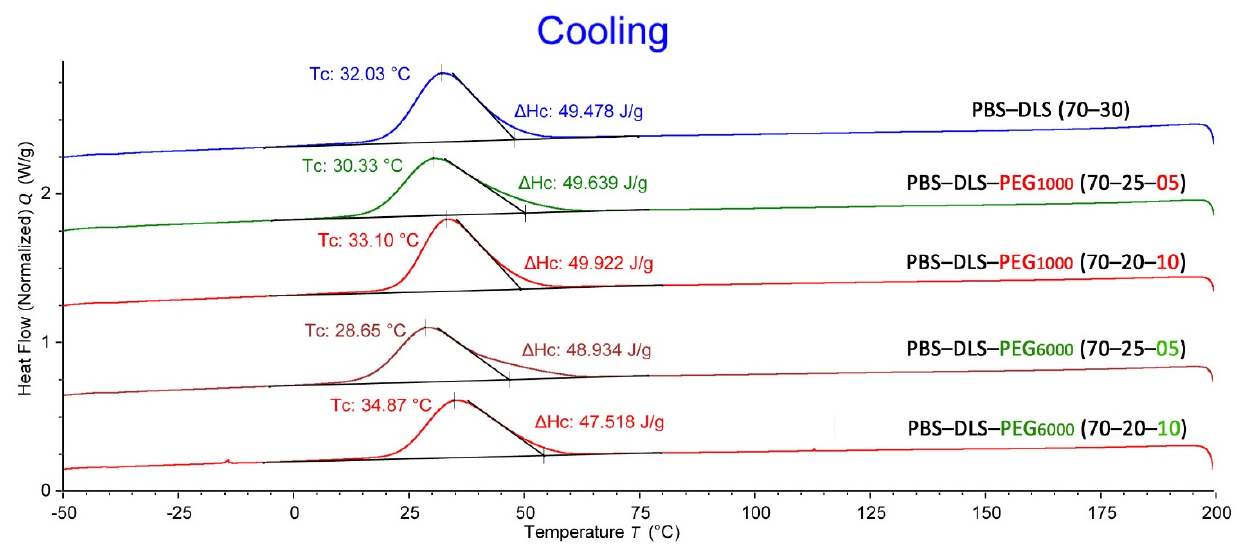
Figure 6. The second heating DSC thermograms for PBS-DLS, PBS-DLS-PEG 1000 and PBS-DLS-PEG 6000 of different segmental compositions.